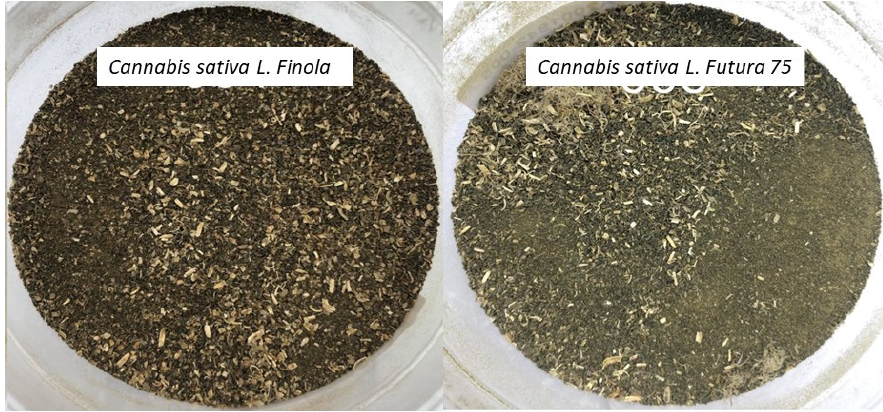
Figure 4. Milled hemp samples of Cannabis sativa L. Finola and Cannabis sativa L. Futura 75 .